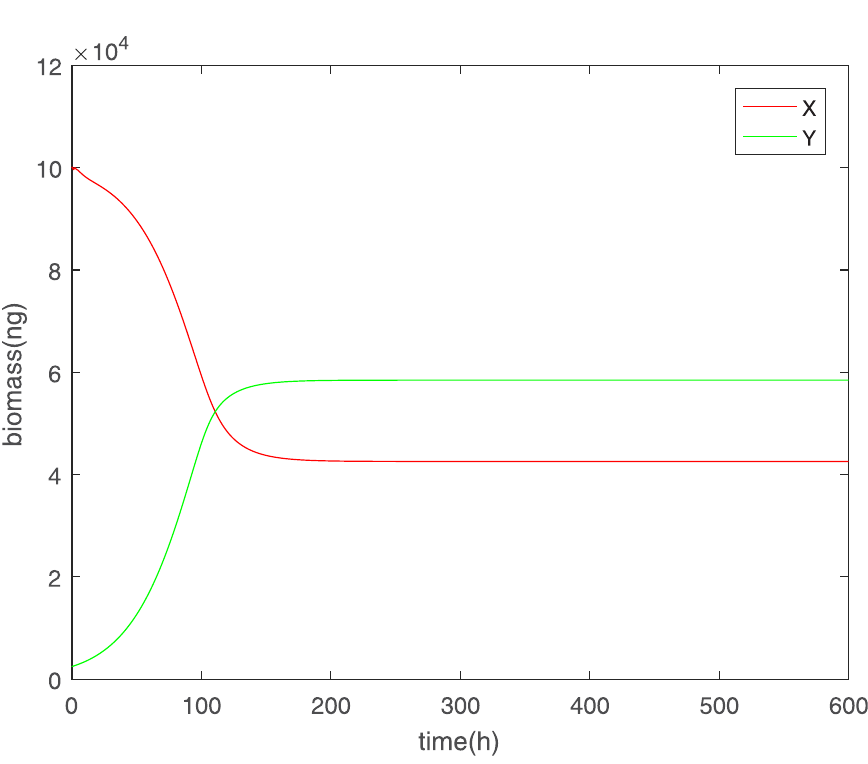
Fig 4. Evolution and steady state of competing populations without delay in the sensing of the biomass by population y but the same parameters as in the previous simulations.